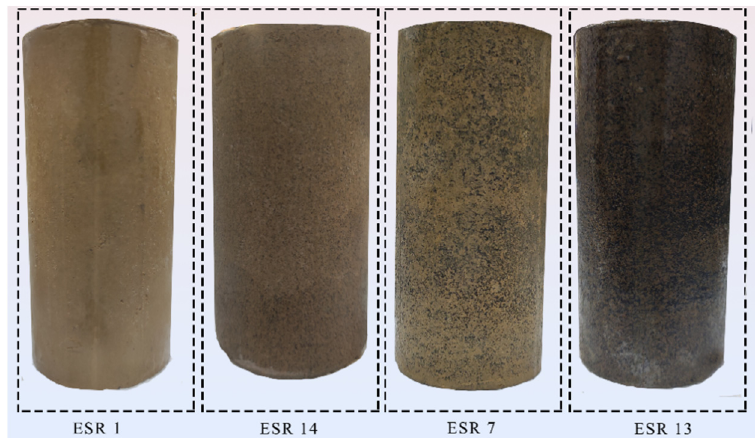
Figure 4. Standard specimens of different rubbery contents.